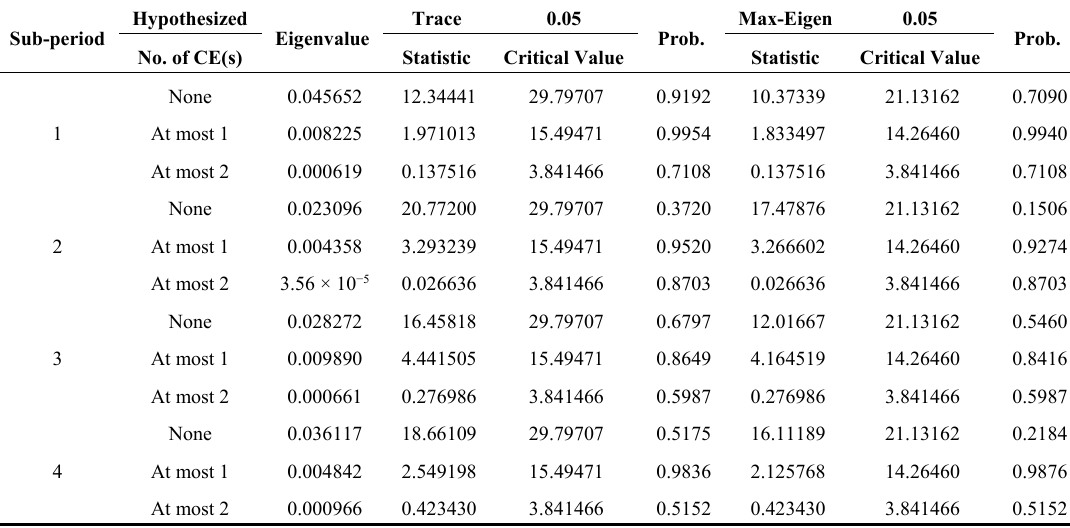
Table A13. Test for Possible Regional Cointegration in Latin